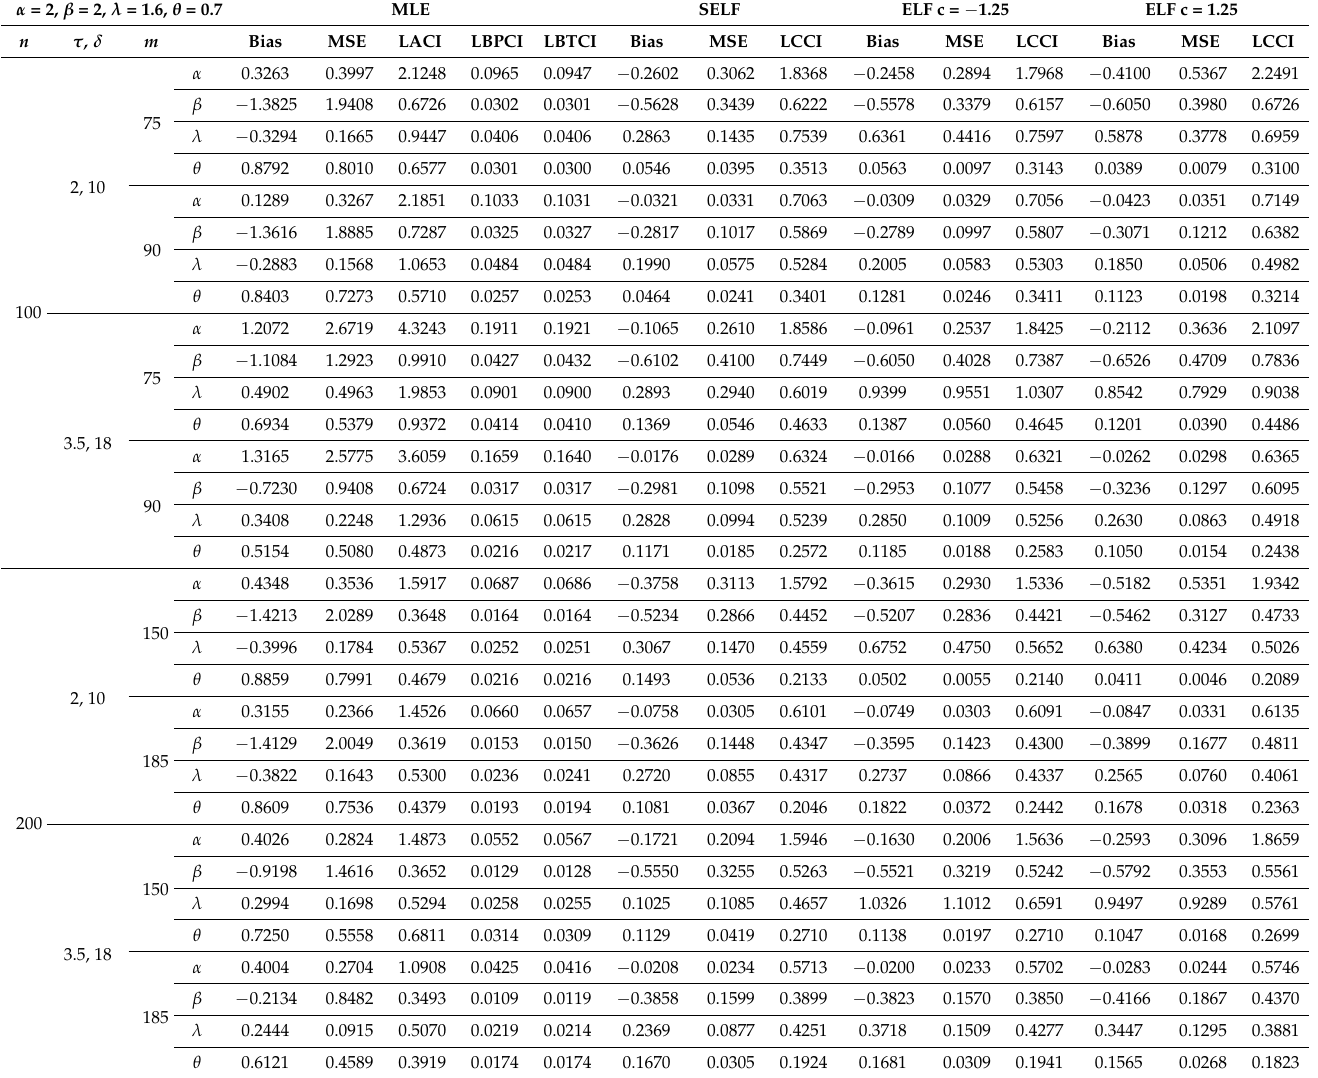
Table 2. Bias, MSE, LACI, LBCI, and LCCI with scheme 1 in case